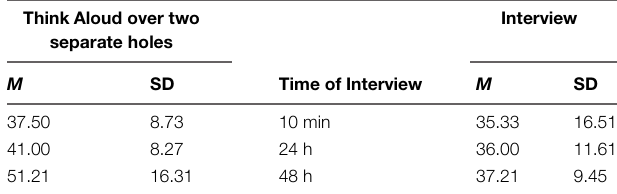
TABLE 6 | Number of first-order themes identified during TA of two separate holes (during performance) and interview at the three time conditions; 10 min, 24h, and 48 h after performance.